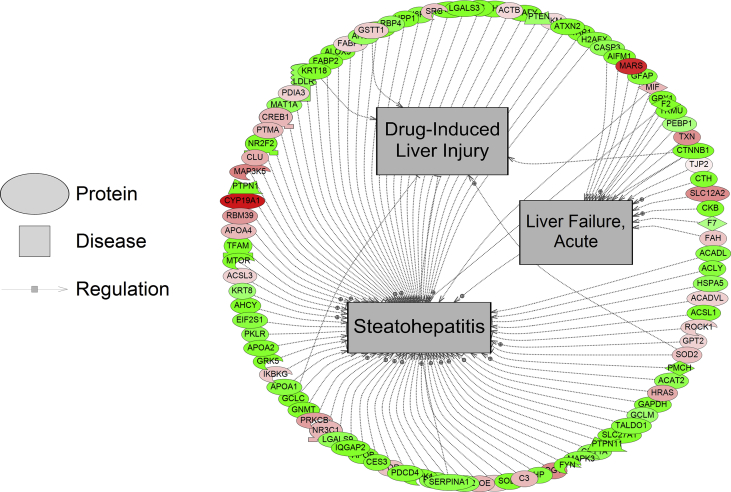
Protein network for drug induced liver injury, acute liver failure and steatohepatitis. Protein data were generated using iTRAQ proteomics. Red indicates that protein levels are increased for that protein and green indicates that the protein levels are decreased relative to control. The more intense the color, the larger the relative fold change of the protein compared to the control group. Circles indicate proteins, mushroom shaped entities with notches along the side represent receptors, while mushroom-shaped entities with notches on the bottom refer to transcription factors. Abbreviations are provided in Supplemental Data 4.